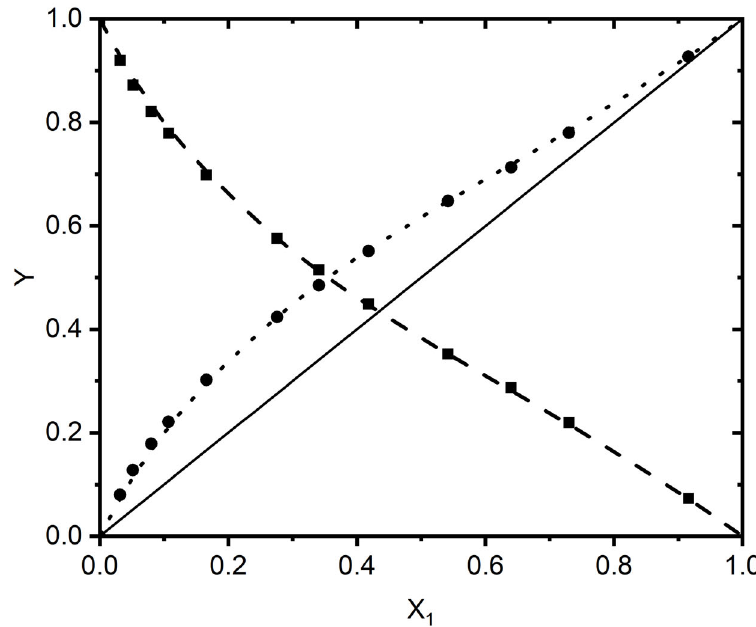
Figure 4. Predicted vapor mole fractions Y 1 (. . . .) of n-heptane and Y 2 (- - - -) for toluene in the binary system n-heptane(1)-toluene(2) at 25 ◦ C [5] in comparison with experimental values ( • ) and ( ▲ ).